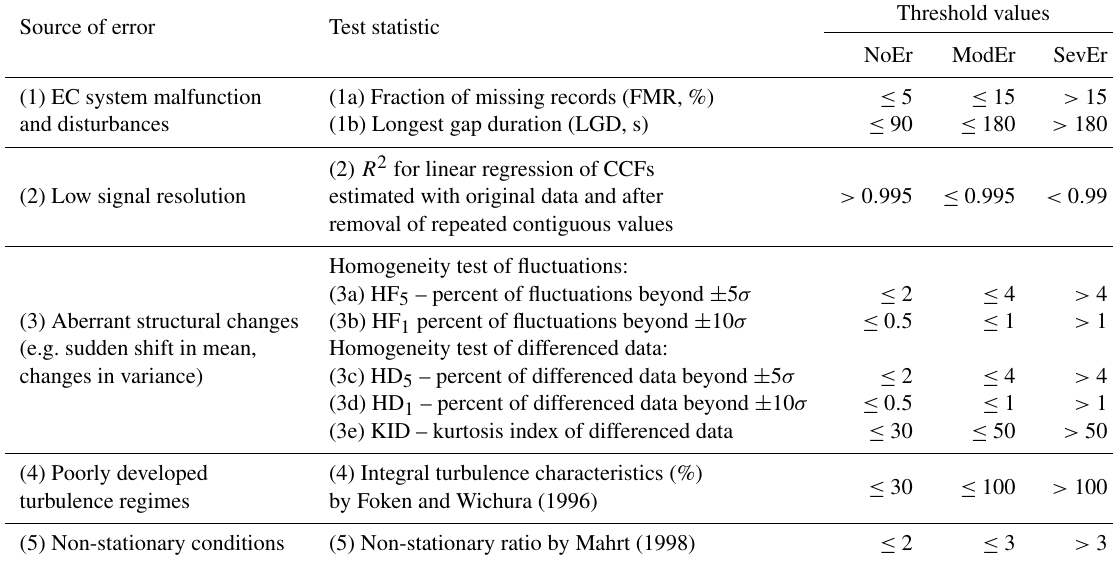
Table 1. Sources of systematic error, test statistics and adopted threshold values to define NoEr, ModEr and SevEr statements. Details on how the threshold values have been set are provided in Sect.